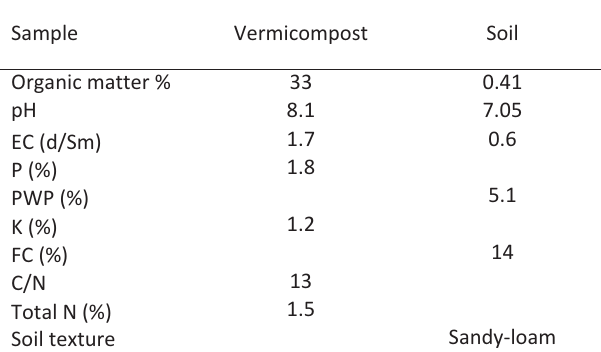
Table 1 - Some physico-chemical properties of vermicompost and